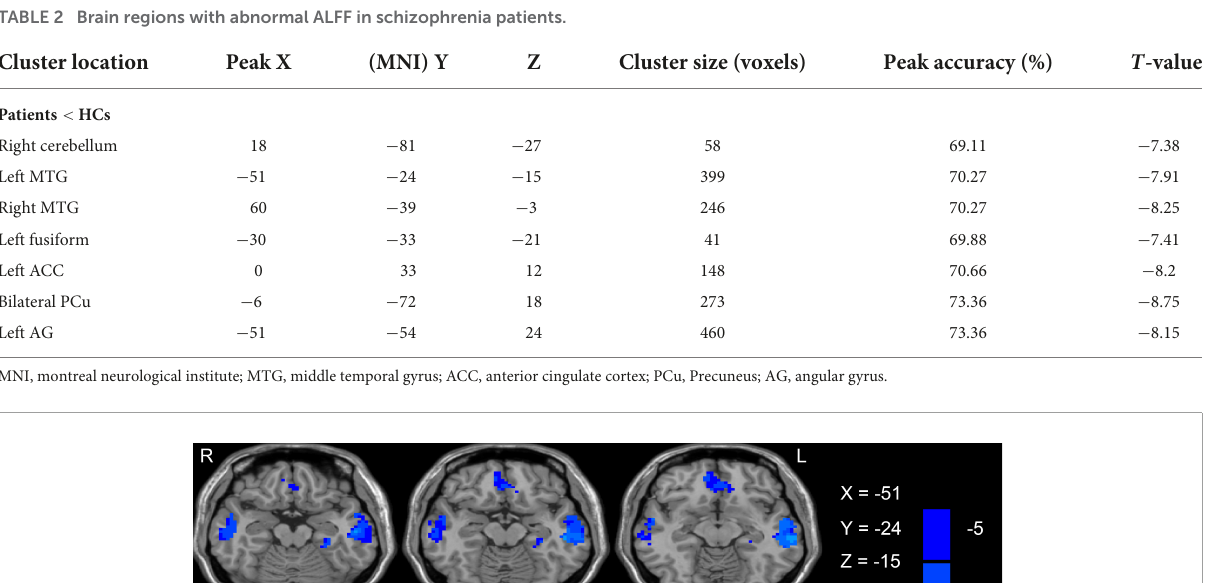
central anterior gyrus in childhood- and adolescent-onset SCH, with auditory hallucination incidence being associated with abnormal activity in these regions (42). These